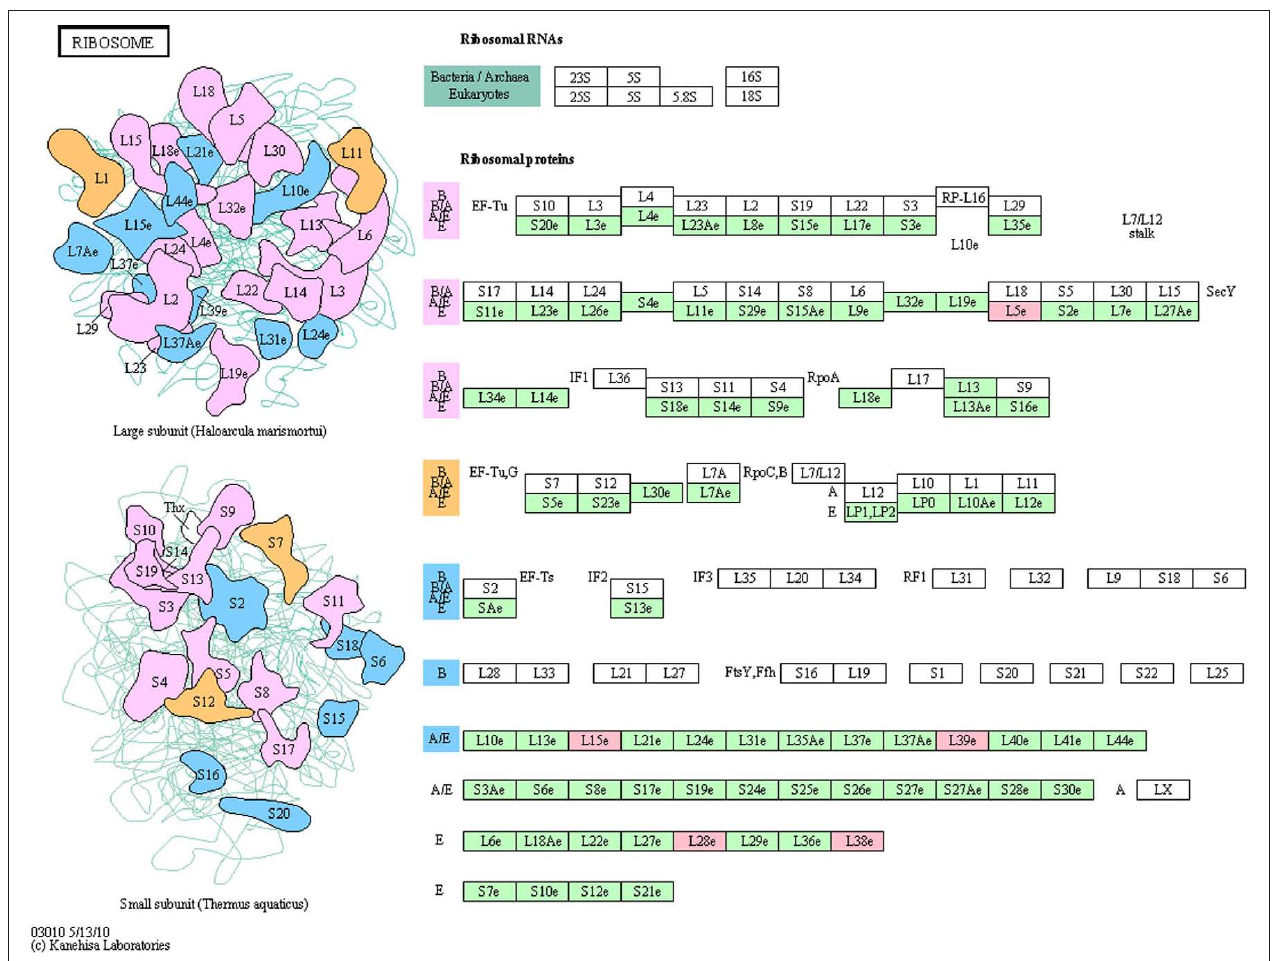
protein L38), RpL39 (Ribosomal protein L39), and RpL5 (Ribosomal protein L5). Green boxes represent other members in the pathway database for Drosophila melanogaster